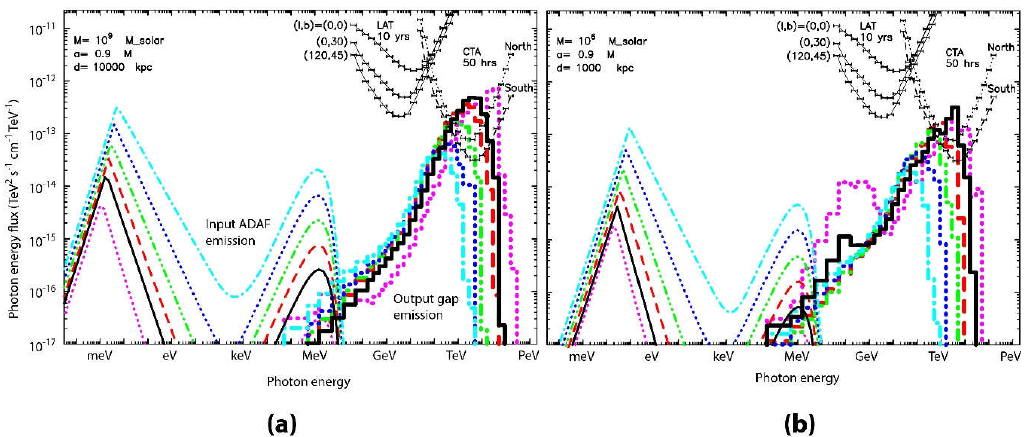
Figure 18. SED of the gap emission for a supermassive BH with a = 0.9 M . The thin curves denote the input ADAF spectra, while the thick lines denote the output gap spectra. The thin solid curves (with horizontal bars) denote the Fermi/LAT detection limits after 10 year of observation, while the thin dashed and dotted curves (with horizontal bars) denote the CTA detection limits after 50 h of observation. ( a ) The case of M = 10 9 M ʘ . The distance is set to be 10 Mpc. The cyan dot-dashed, blue dotted, green triple-dot-dashed, red dashed, black solid, and purple dotted curves correspond to m = 1.77 × 10 −4 , 1.00 × 10 −4 , 5.62 × 10 −5 , 3.16 × 10 −5 , 1.77 × 10 −5 , and 5.62 × 10 −6 , respectively. Magnetic field strength is assumed to be the equipartition value with the plasma accretion. ( b ) The case of M = 10 6 M ʘ . The distance is set to be 1 Mpc. The cyan dot-dashed, blue dotted, green triple-dot-dashed, red dashed, black solid, and purple dotted curves correspond to m = 3.16 × 10 −4 , 1.00 × 10 −4 , 5.62 × 10 −5 , 4.21 × 10 −5 , 3.16 × 10 −5 , and 1.77 × 10 −5 , respectively. From [63].